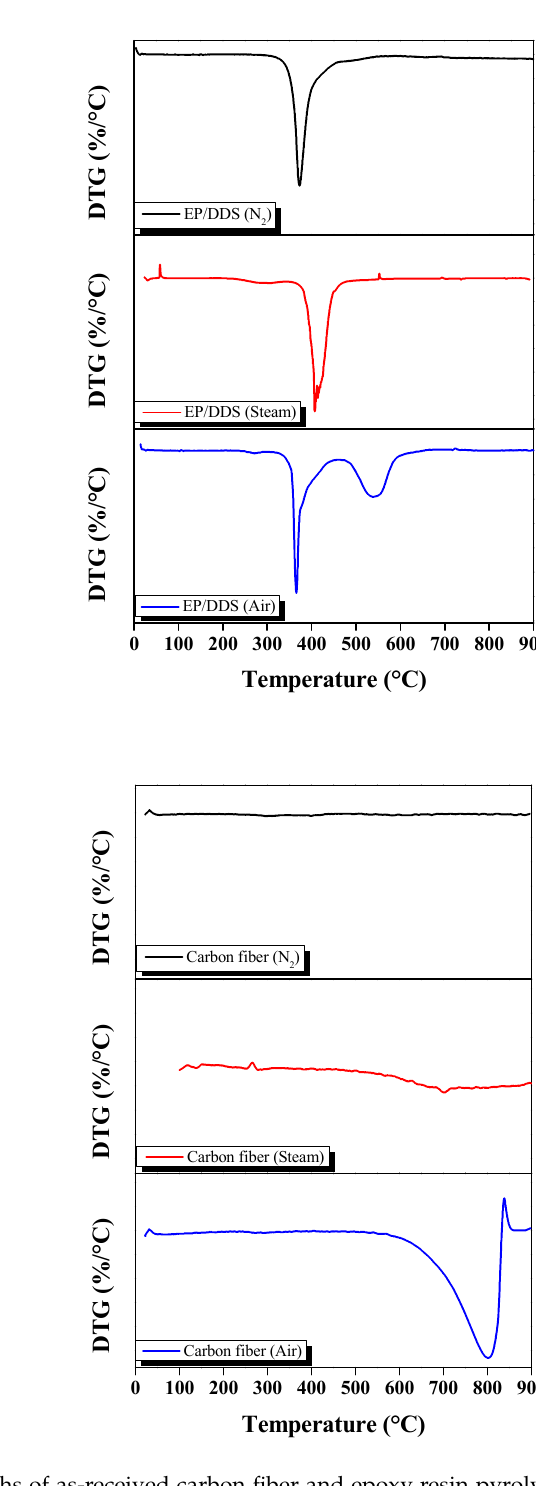
Figure 4. TGA and DTG graphs of as-received carbon fiber and epoxy resin pyrolysis under gas atmosphere: ( a ) cured epoxy/4,4 ′ -diaminodiphenyl sulfone and ( b ) carbon fiber.